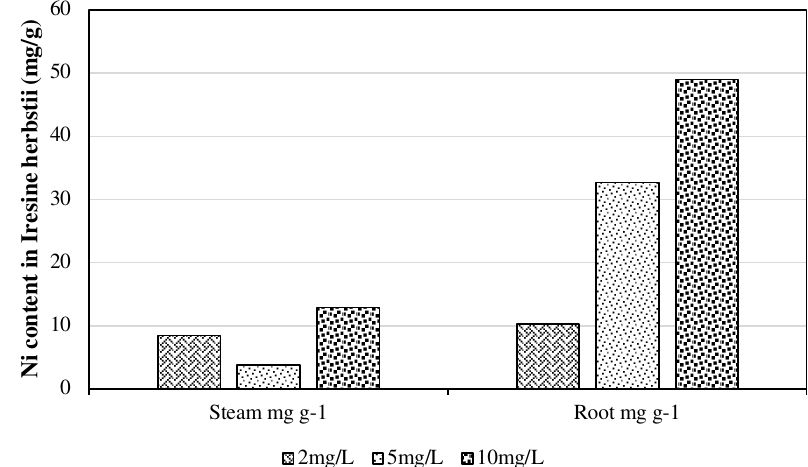
Fig. 4. Nickel in Iresine herbstii.